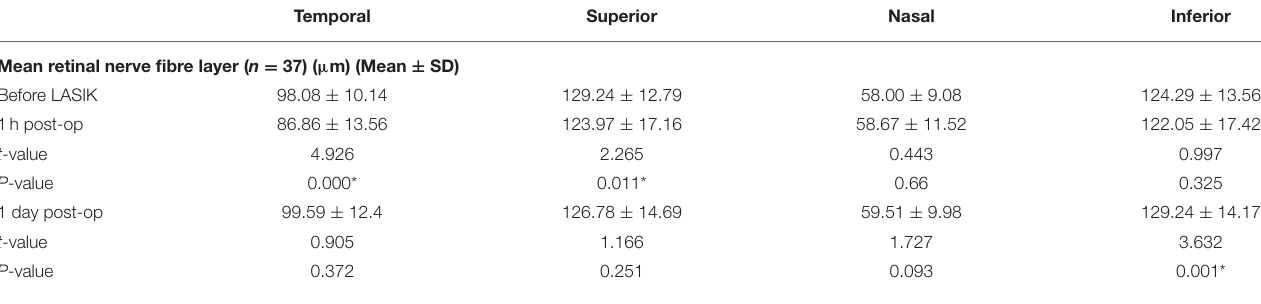
TABLE 2 | Mean retinal nerve fibre layer thickness before and after FS-LASIK surgery.